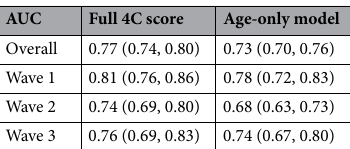
Table 3. Area under the receiver operating characteristic curve (AUC) for 4C score and age-only model overall and by wave.